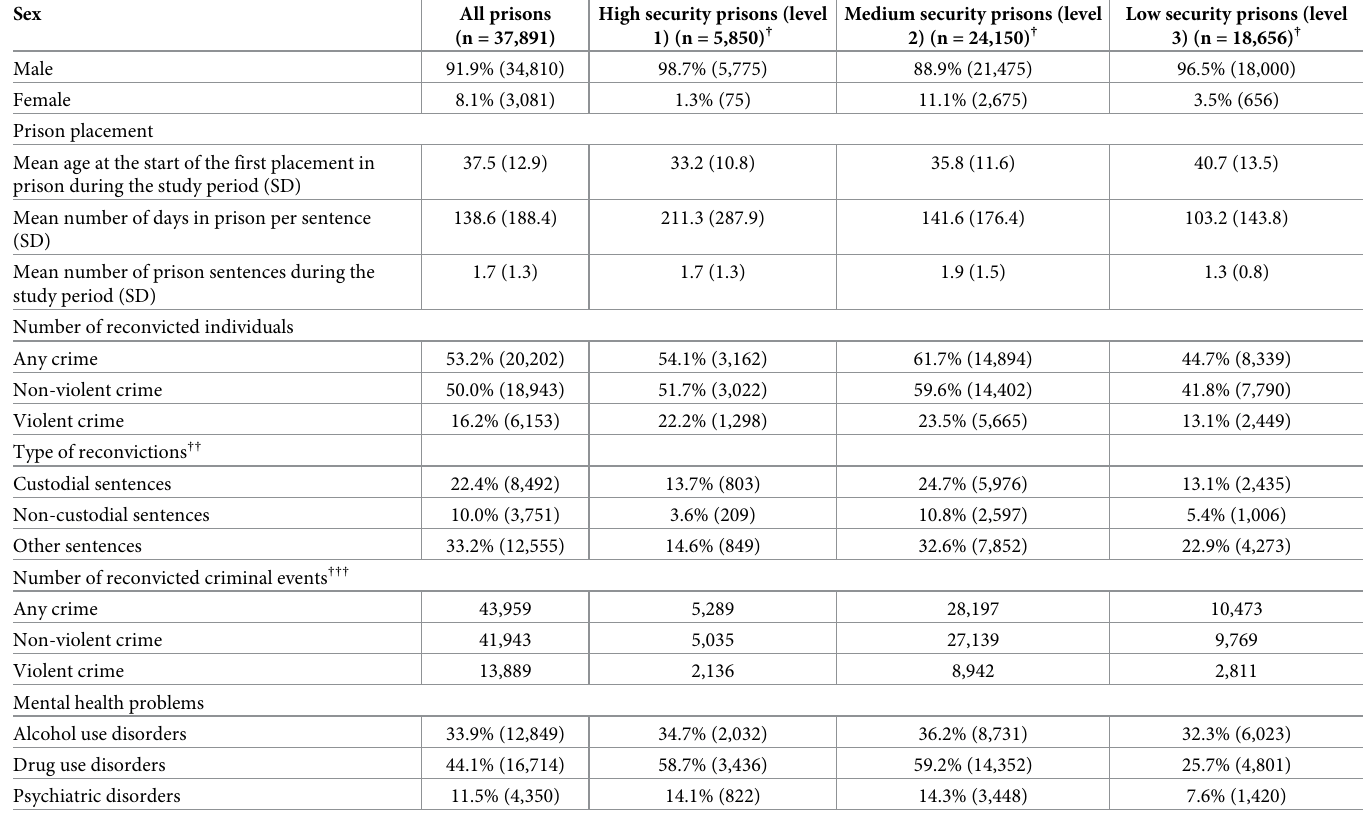
Table 1. Characteristics of a cohort of 37,891 prisoners followed 2006 to 2013 in Sweden.